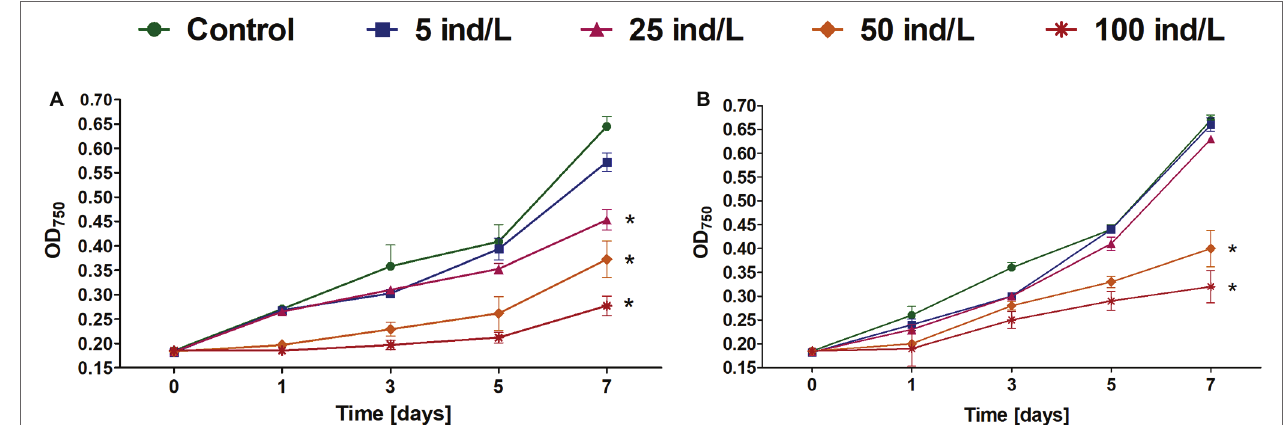
FIGURE 1 | The growth (mean and SD) of Microcystis aeruginosa exposed for 7 days to different concentrations of Daphnia magna (A) and Daphnia cucullata (B) ( n = 5). An asterisk indicates a significant difference with the control ( p < 0.05; Mann-Whitney U test).